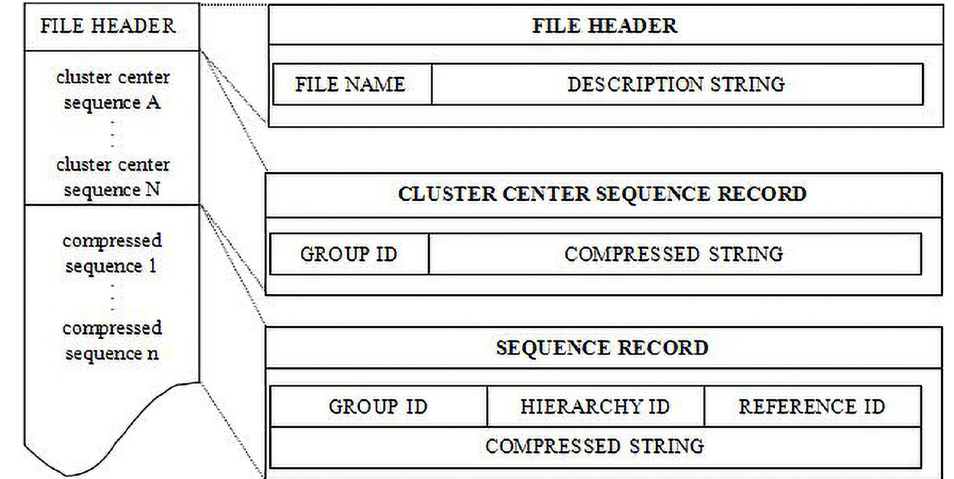
Fig 3. Compressed file structure. The general structure is shown on the left. The detailed description of every compressed sequence is shown on the right. Refer to the text for details.